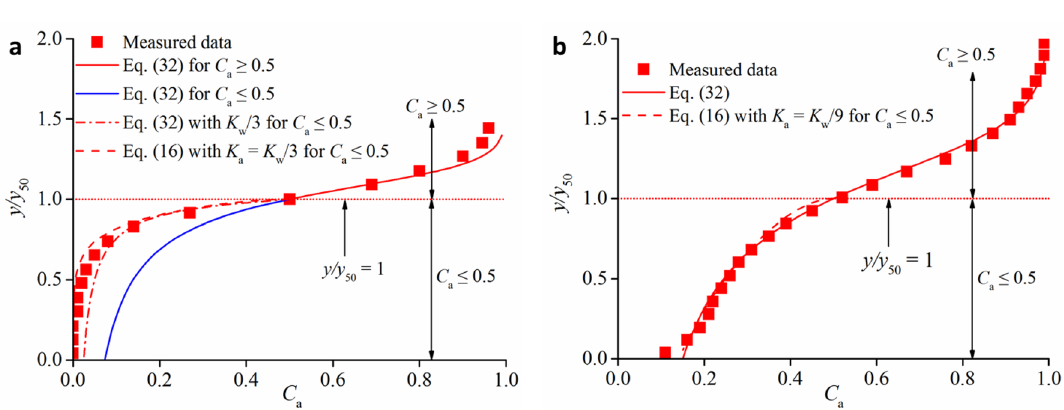
Figure 4. Air concentration distribution for fully and partially aerated diffusions: ( a ) C mean = 0.23, ( b ) C mean =